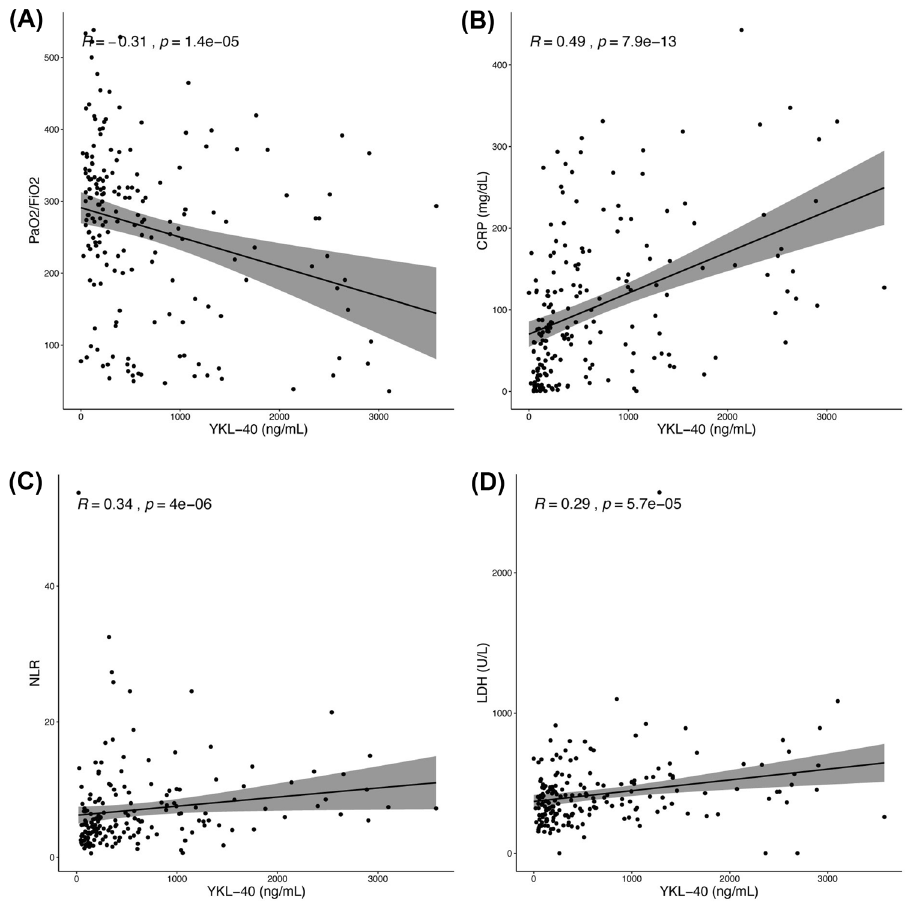
Figure 2. Correlations of CHI3L1 plasma levels with PaO 2 /FiO2, CRP, NLR and LDH levels. Spearman’s test was used to correlate CHI3L1 levels with PaO 2 /FiO2 ( A ), CRP ( B ), NLR ( C ) and LDH ( D ) values at the hospital admission.